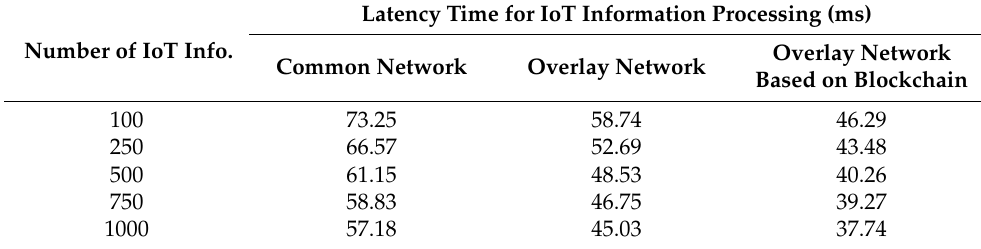
Table 5. Latency time for IoT information processing in a blockchain-based overlay network.